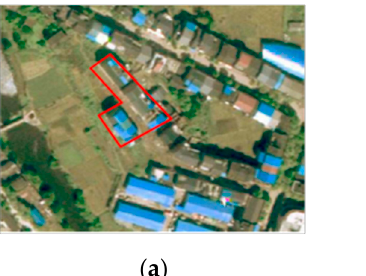
Figure 3. Identification of ( a ) unauthorized construction and ( b ) undiminished unauthorized structures.